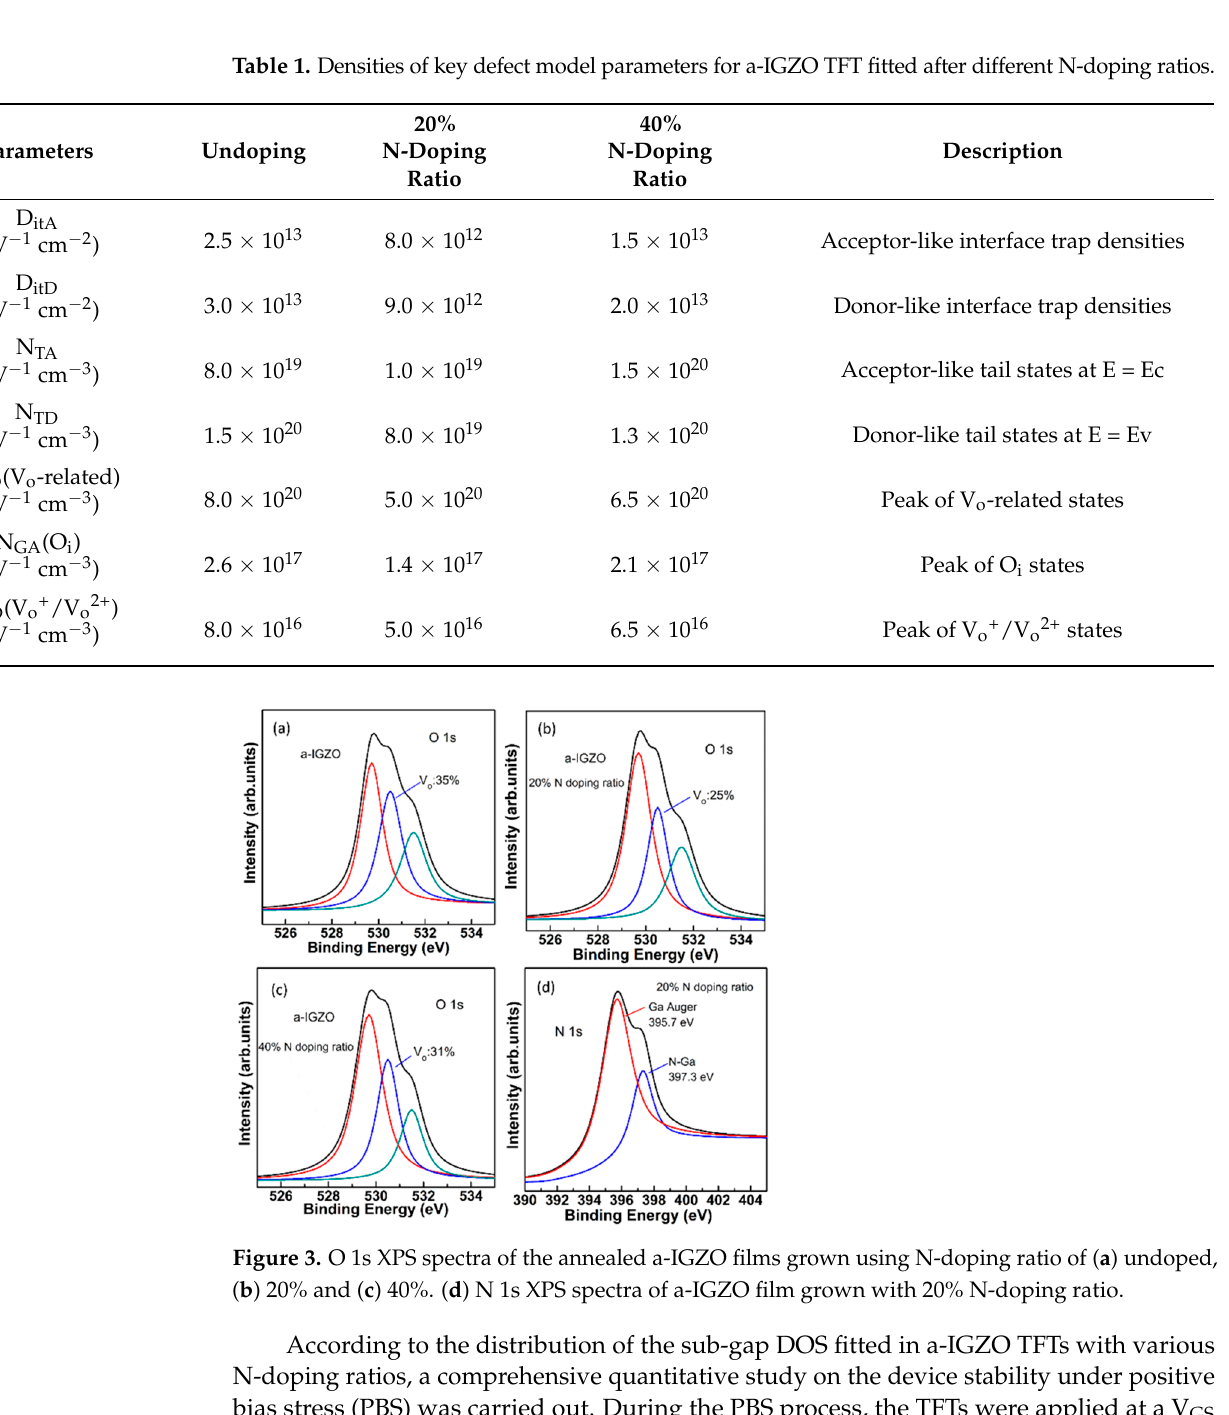
Figure 4. Depth profile of nitrogen in a-IGZO film deposited under 20% N-doping ratio and 40% N- doping ratio. Table 1. Densities of key defect model parameters for a-IGZO TFT fitted after different N-doping ratios. Parameters